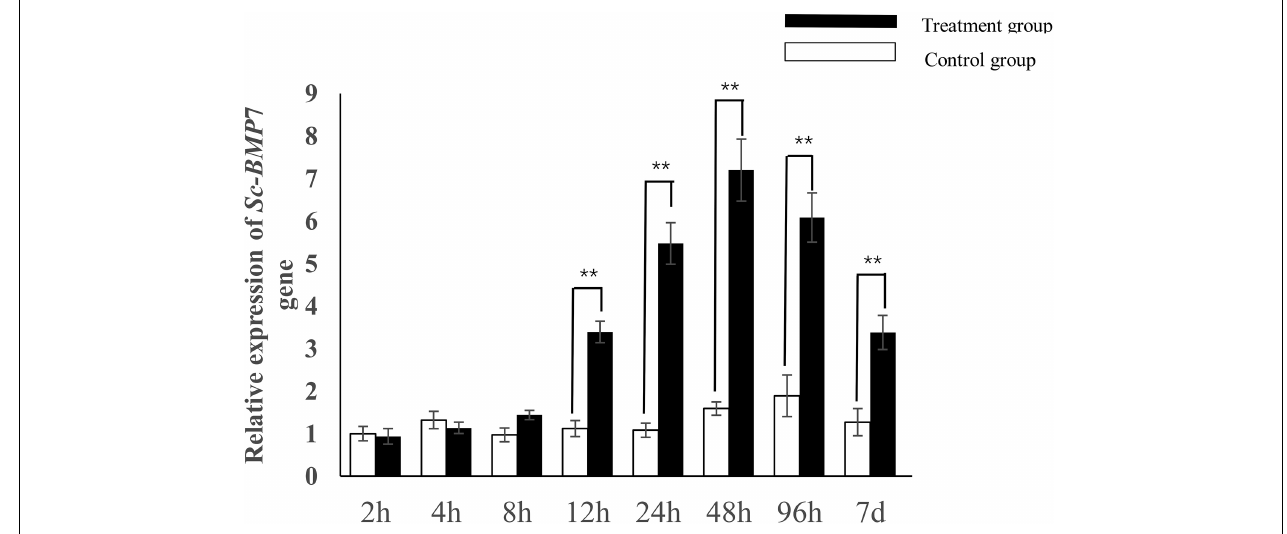
FIGURE 3 | Quantitative expression analysis of Sc-BMP 7 after shell notching. ∗∗ represents extremely significant differences, P < 0.01.